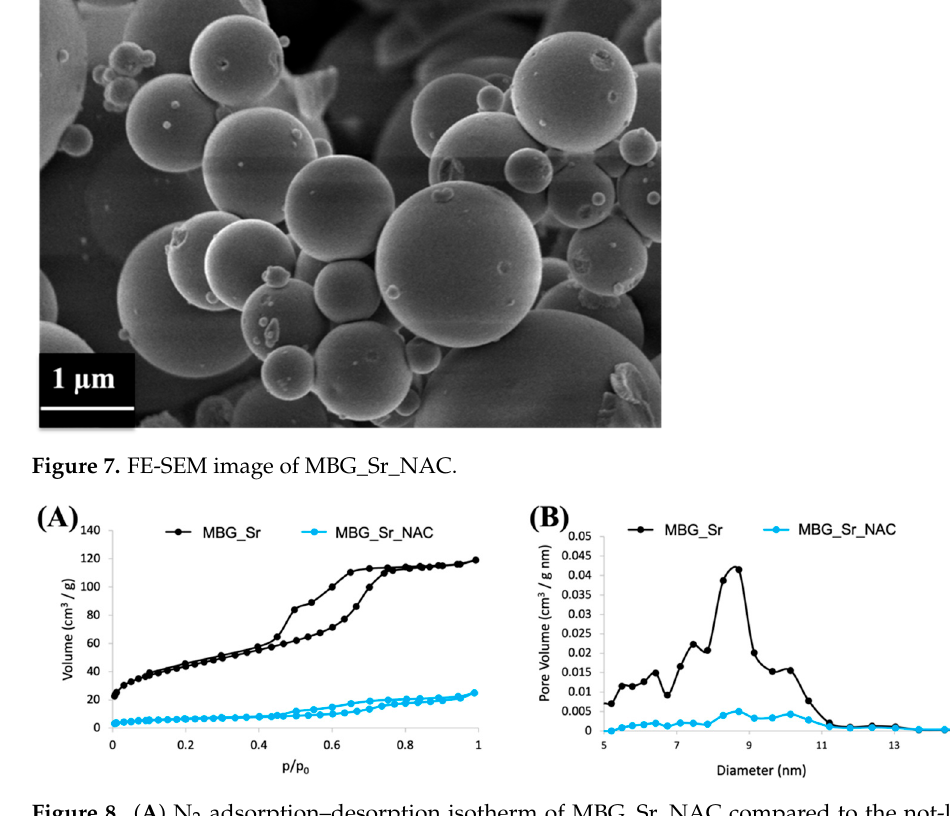
Figure 8. ( A ) N 2 adsorption–desorption isotherm of MBG_Sr_NAC compared to the not-loaded sample ( A ) and ( B ) related DFT pore size distribution ( B ).